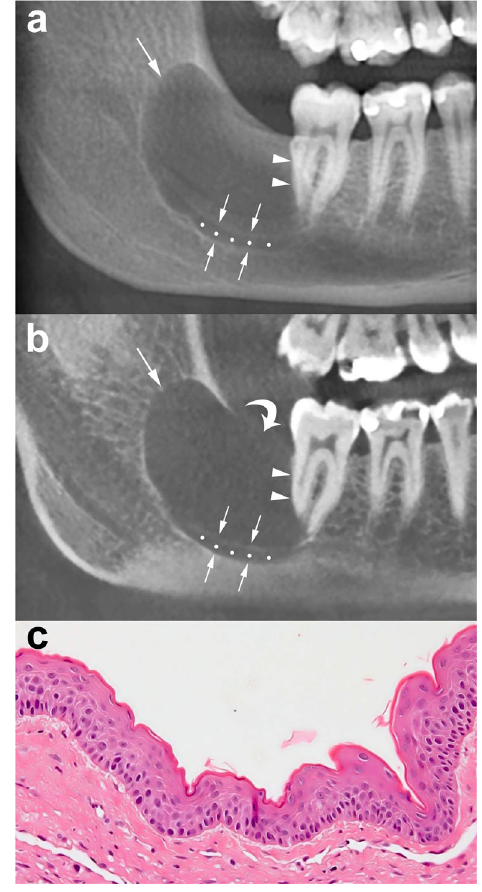
Fig. 10 Panoramic CBCT images with 20-mm ( a ) and 0.5-mm ( b ) slice thickness of an OKC show a unilocular lesion with well-defined and corticated margins located in the posterior sextant and ramus of the right mandible ( arrows ), near the distal root of the second molar ( arrowheads ). Note the interruption of the superior border of the retromolar region ( curved arrow ) and inferior displacement of the mandibular canal ( opposing arrows and dots ). c Histological image shows the typical parakeratinised stratified squamous epithelial lining with corrugated surfaces (H-E